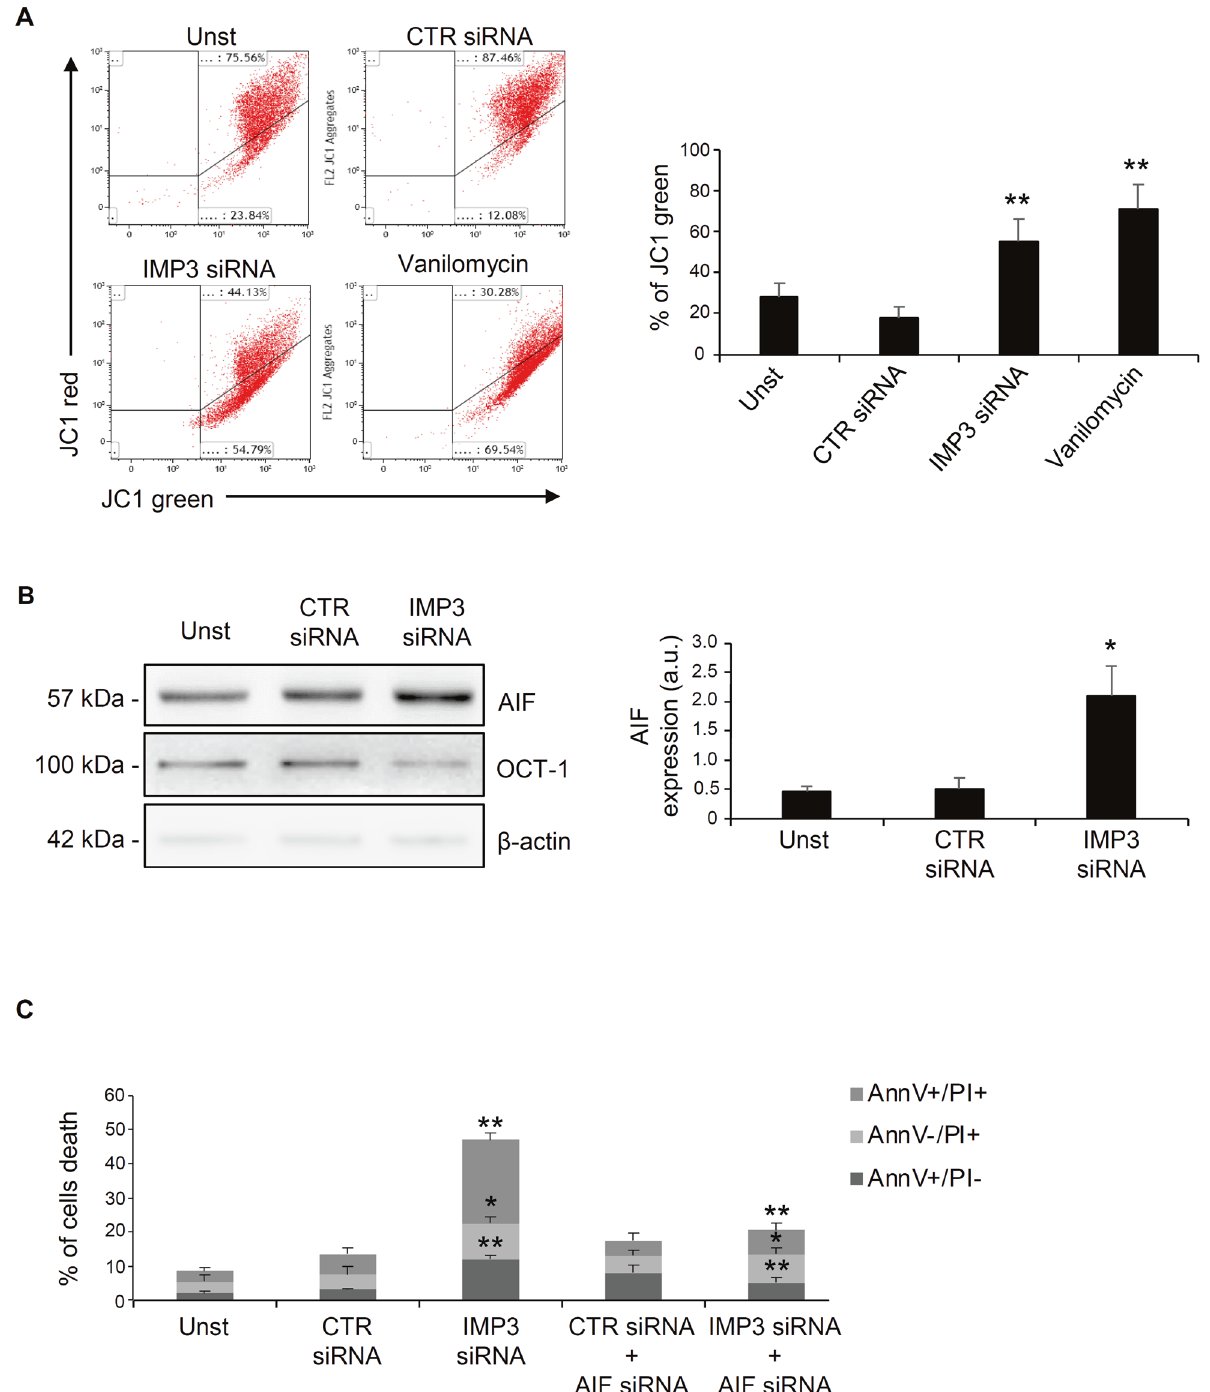
Fig. 6 IMP3 knockdown affects mitochondrial membrane potential and AIF nuclear accumulation. ( A ) HCT-116 cells were left untreated (Unst) or transfected with CTR or IMP3 siRNA. Vanilomycin was used as positive control. HCT-116 were stained with JC-1 and analyzed by fl ow cytometry. Mitochondrial membrane potential loss was evaluated as a decrease in JC-1 red fl uorescence and an increase in JC-1 green fl uorescence. Representative dot plot (Unst and CTR siRNA-treated cells versus IMP3 siRNA-transfected cells and Unst cells versus vanilomycin- treated cells, mean ± SD, ** P ≤ 0.01; n = 3). B Representative Western blot (left panel) and quantitative analysis (right panel) for AIF, OCT-1 and β -actin in nuclear protein extracted from HCT-116 cells untreated (Unst) or transfected with CTR or IMP3 siRNA for 48 h. (Unst and CTR siRNA- treated cells versus IMP3 siRNA-transfected cells, mean ± SD, ** p ≤ 0.01; n = 3). C Percentage of AnnV and/or PI-positive HCT-116 cells untreated (Unst) or transfected with CTR or IMP3 siRNA in presence/absence of AIF siRNA for 48 h (CTR siRNA-treated cells versus IMP3 siRNA- transfected cells, * p = 0.04, ** p ≤ 0.01;and IMP3 siRNA-transfected versus IMP3 siRNA + AIF siRNA transfected cells * p = 0.04, ** p ≤ 0.01; mean ± SD, n = 3).